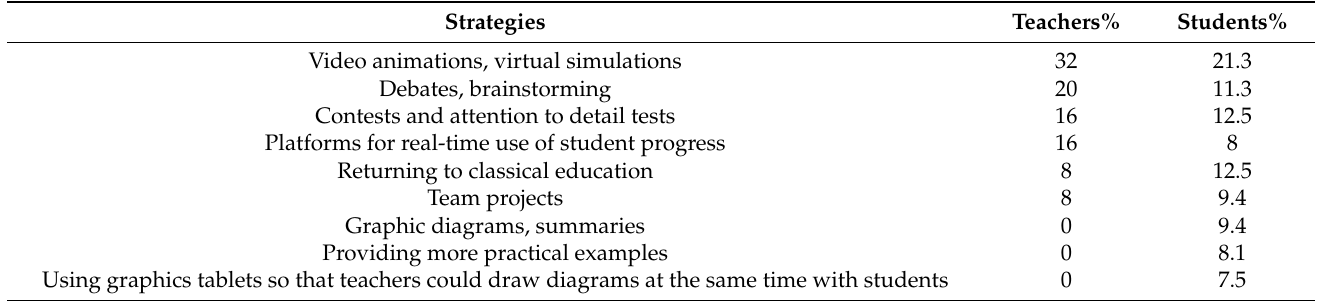
Table 12. The most useful online teaching strategies.